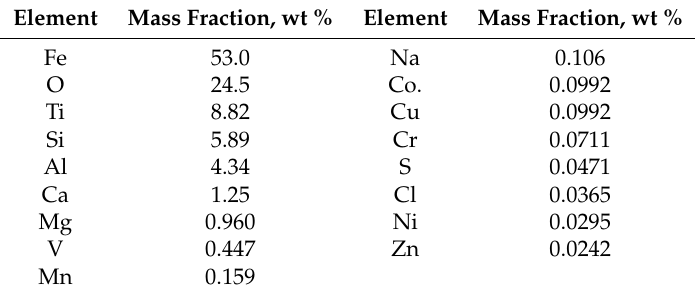
Table 3. The elemental composition of the ore (ICP). Element Mass Fraction, wt %